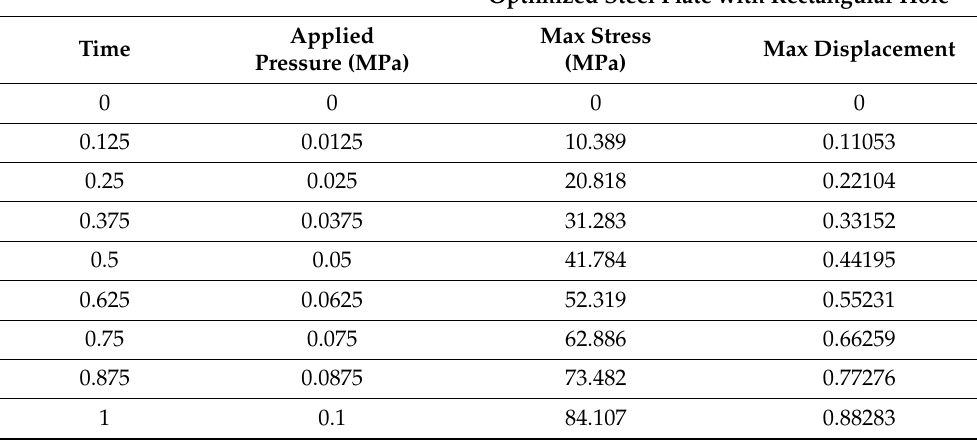
Table 5. Maximum stresses and displacement values for the optimised steel plate with rectangular hole with respect to